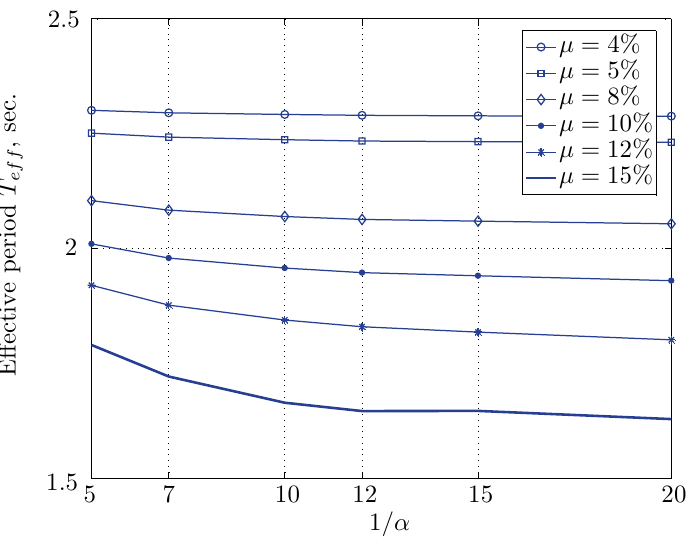
Figure 33. Effective period for various isolation system parameters